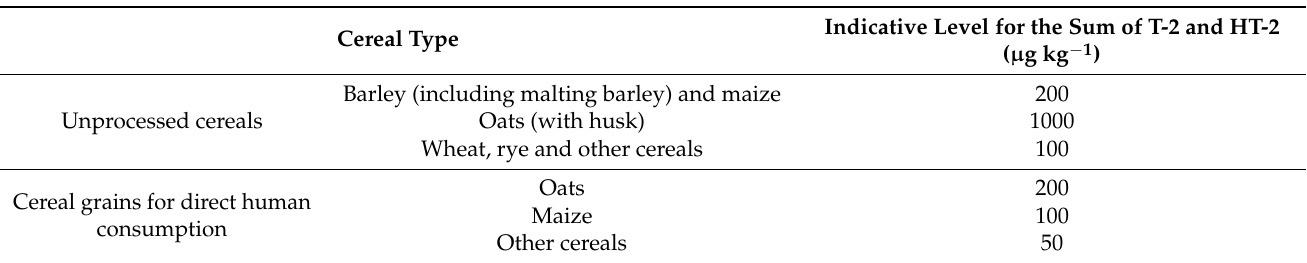
Table 1. Indicative legal limits for the sum of T-2 and HT-2 in cereals (European Commission Recommendation of 27 March